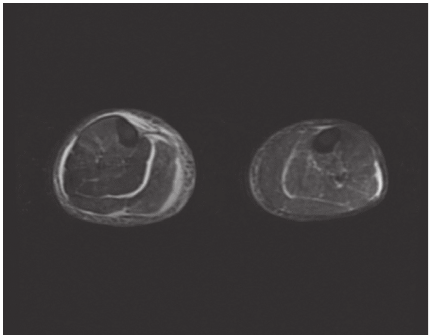
Figure 3: Horizontal section of magnetic resonance imaging (MRI) of lower extremities, with and without contrast, showing edema within the fascial compartments between the right gastrocnemius and right soleus muscles, as well as in the superficial fascia. A crescent-shaped subfascial fluid collection was also noted over the medial head of the right gastrocnemius muscle, indicative of